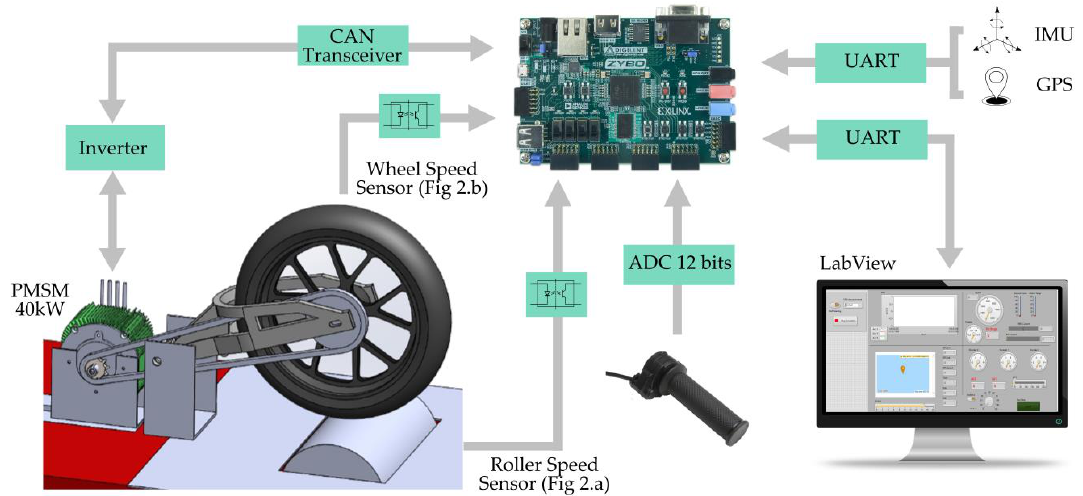
Figure 3. Connection diagram of the system components.